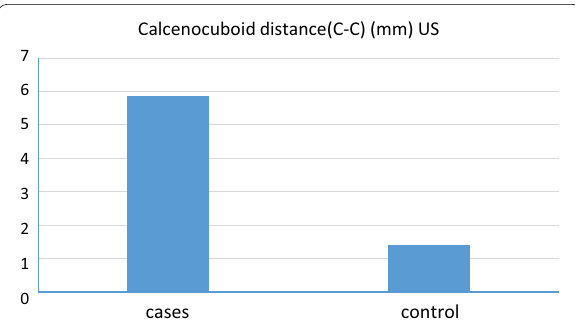
Fig. 3 Correlation of the calcaneocuboid distance (C–C) measured by US in patients and controls